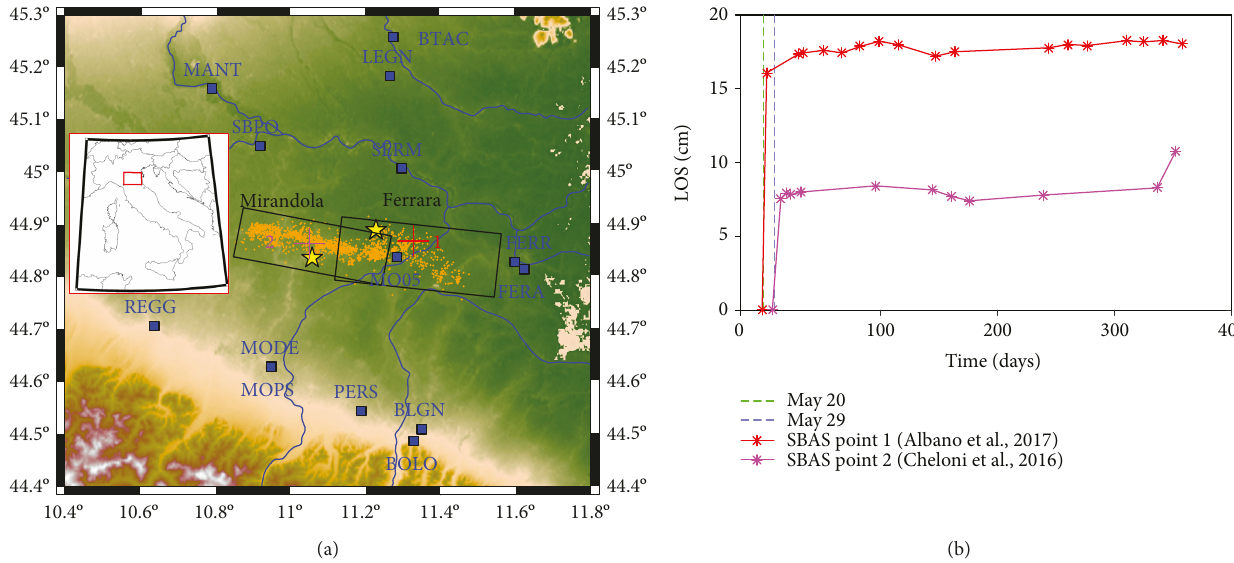
Figure 1: (a) Map of the investigated area. Blue squares: GPS stations. Black rectangles: projection of the two faults at the surface. Orange points: seismic events during the Emilia-Romagna seismic sequence in the fi rst 30 days after the May 20 mainshock [1]. Yellow stars: May 20 (Easternmost) and May 29 (Westernmost) mainshocks epicenters. Red and purple crosses: locations of the InSAR (SBAS) time series at points 1 and 2, respectively. (b) Line of sight (LOS) displacement time series at point 1 (from [18]) and 2 (from